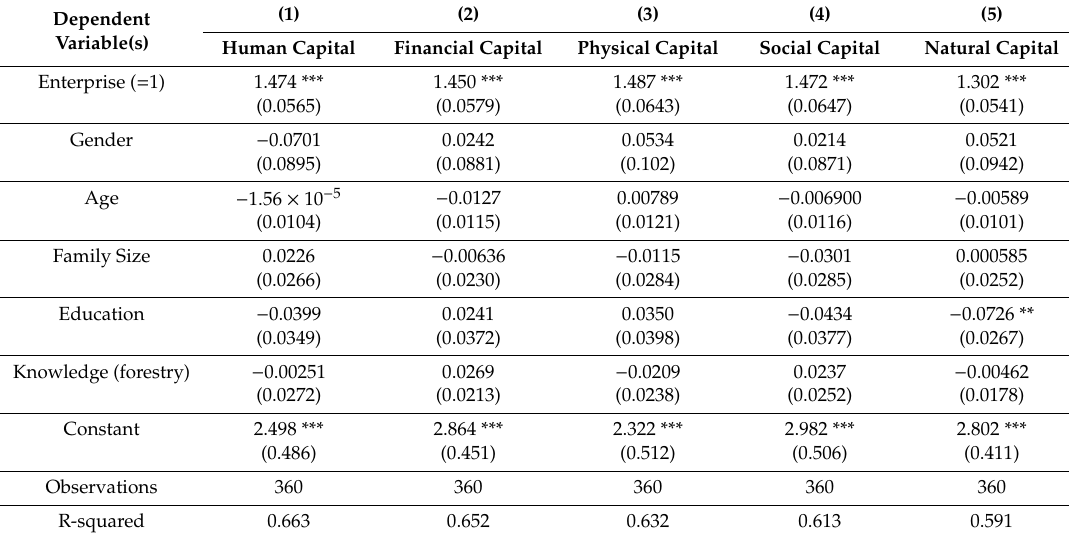
Table 4. BTAP and rural livelihoods.